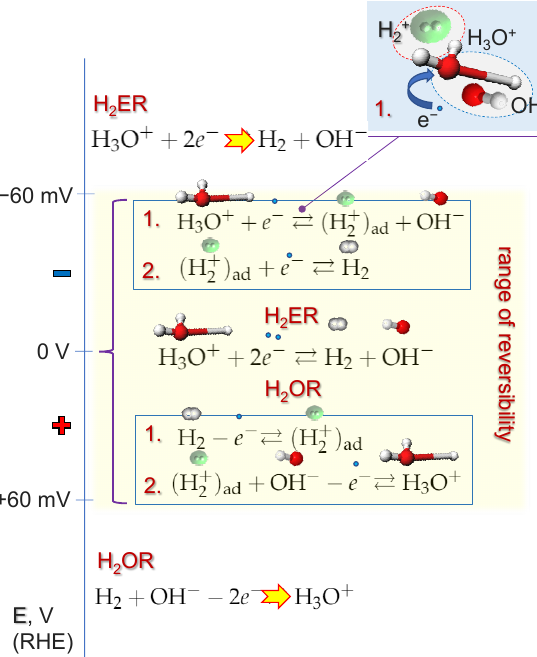
Figure 3. Hydrogen evolution/oxidation reactions H 2 ER/H 2 OR in aqueous solutions; (cid:29) marks reversible processes while the colored arrows in elctrochemical reactions occurring outside the re- versibility range of ± 60 mV mark irreversible processes. E = 0 V vs. RHE corresponds to equilibrium potential of H 2 ER/H 2 OR for a solution with any pH. The inset shows schematics of H + (Equation (5)) using pictorials of chemical structures of the participating species. Addition of expres- sions (1) and (2) in either the positive or negative side leads to the central equation, which defines the equilibrium condition of the SHE (RHE)